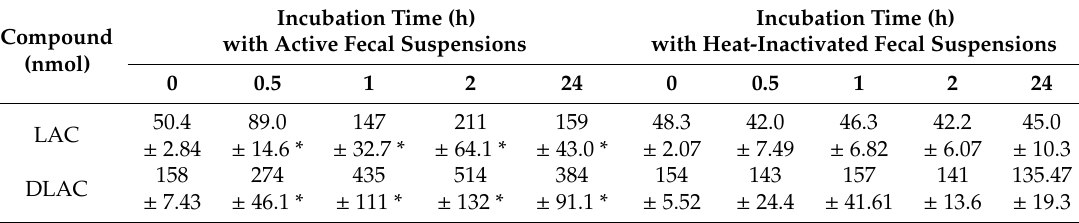
Table 4. Mean content of sesquiterpene lactones detected in active or heat-inactivated fecal suspensions incubated with Brussels / witloof chicory a